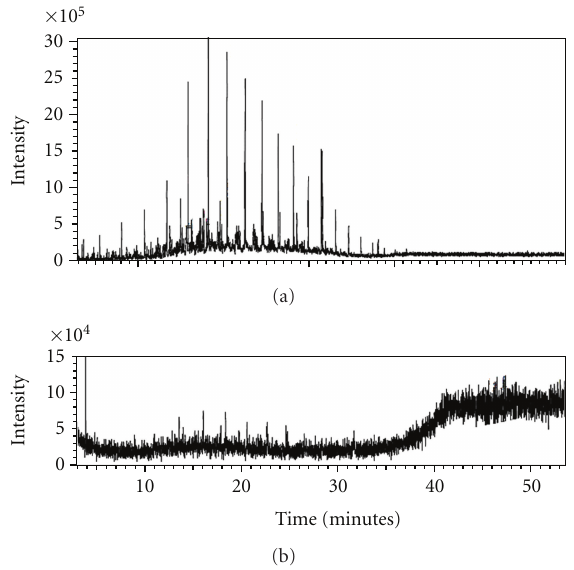
Figure 7: Aliphatic hydrocarbons detected in the system water + 10% diesel/biodiesel with gas chromatography. (a) Before the process and (b) after 15 days of